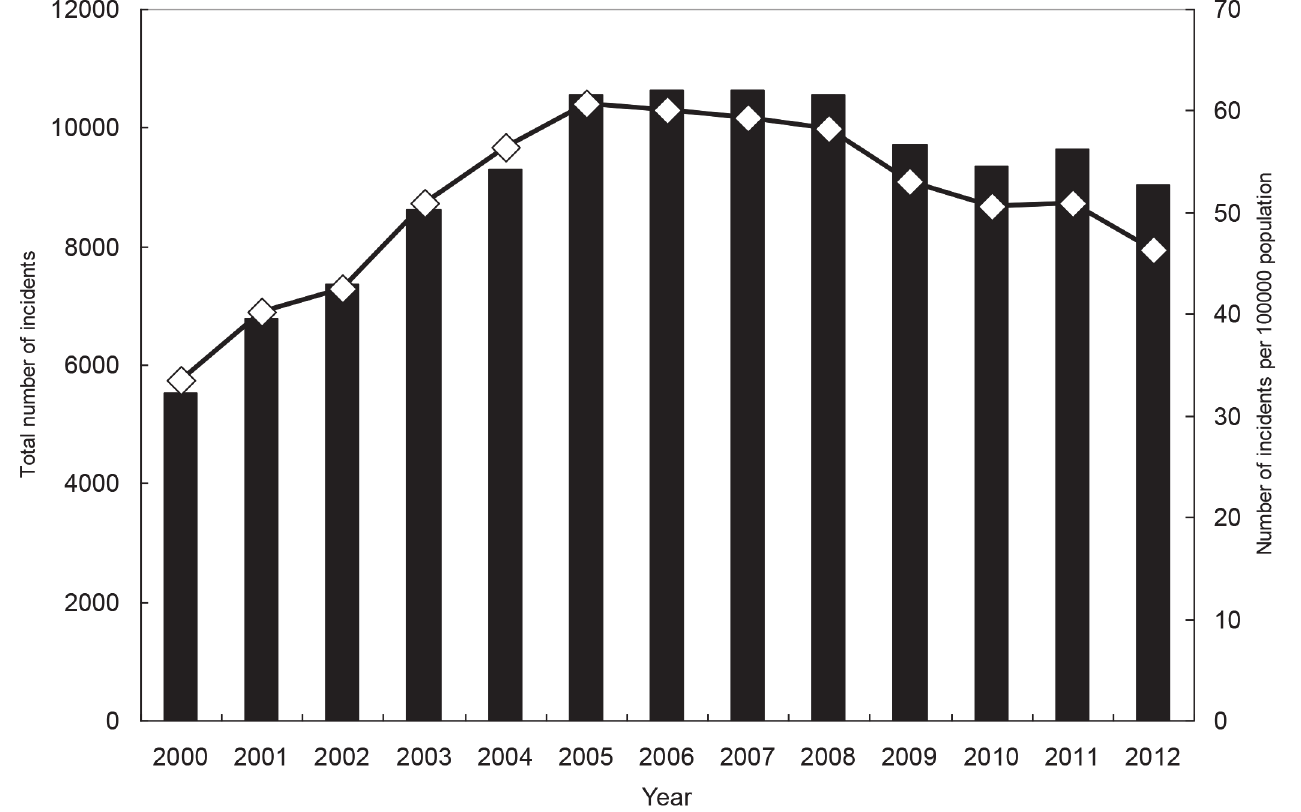
Fig 3. Total numbers of incidents with out-of-hospital cardiac arrest and incident rates, for both genders